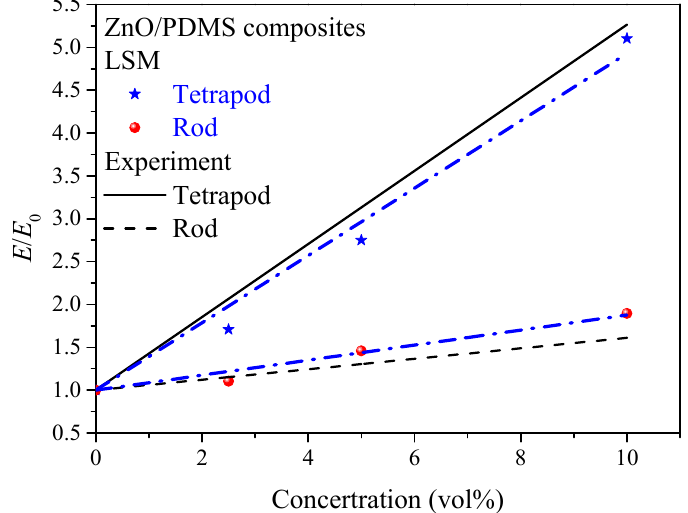
Figure 4. Comparison of experimental results from ZnO/PDMS (Polydimethylsiloxane) composites with simulated data by a lattice spring model. Plot of relative elastic modulus versus nanoparticle concentration for tetrapod and nanorod nanocomposites. Fits are clamped to the (0, 1) point. The experimental data are replotted from Ref. [23] under open access license.